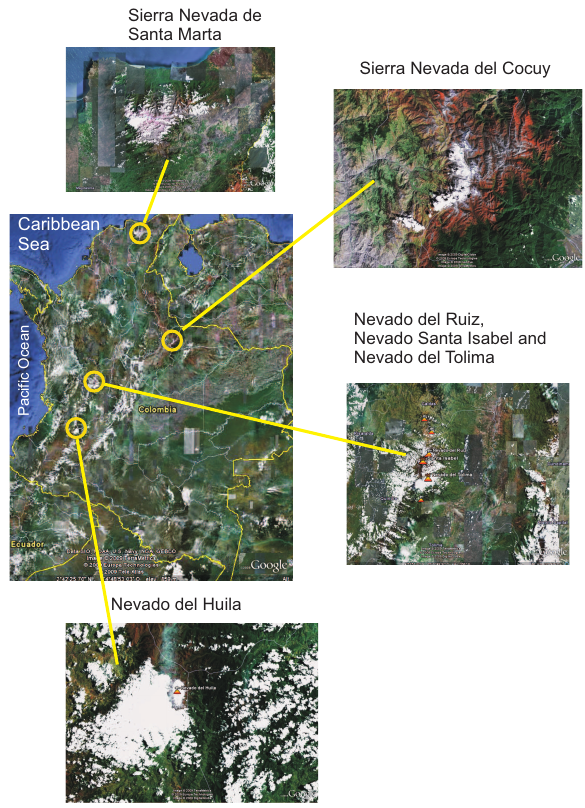
Fig. 1. Location of the six Colombian glacierized mountain ranges studied herein. The figure was made up usingJune12th/2009GoogleEarthimagery.